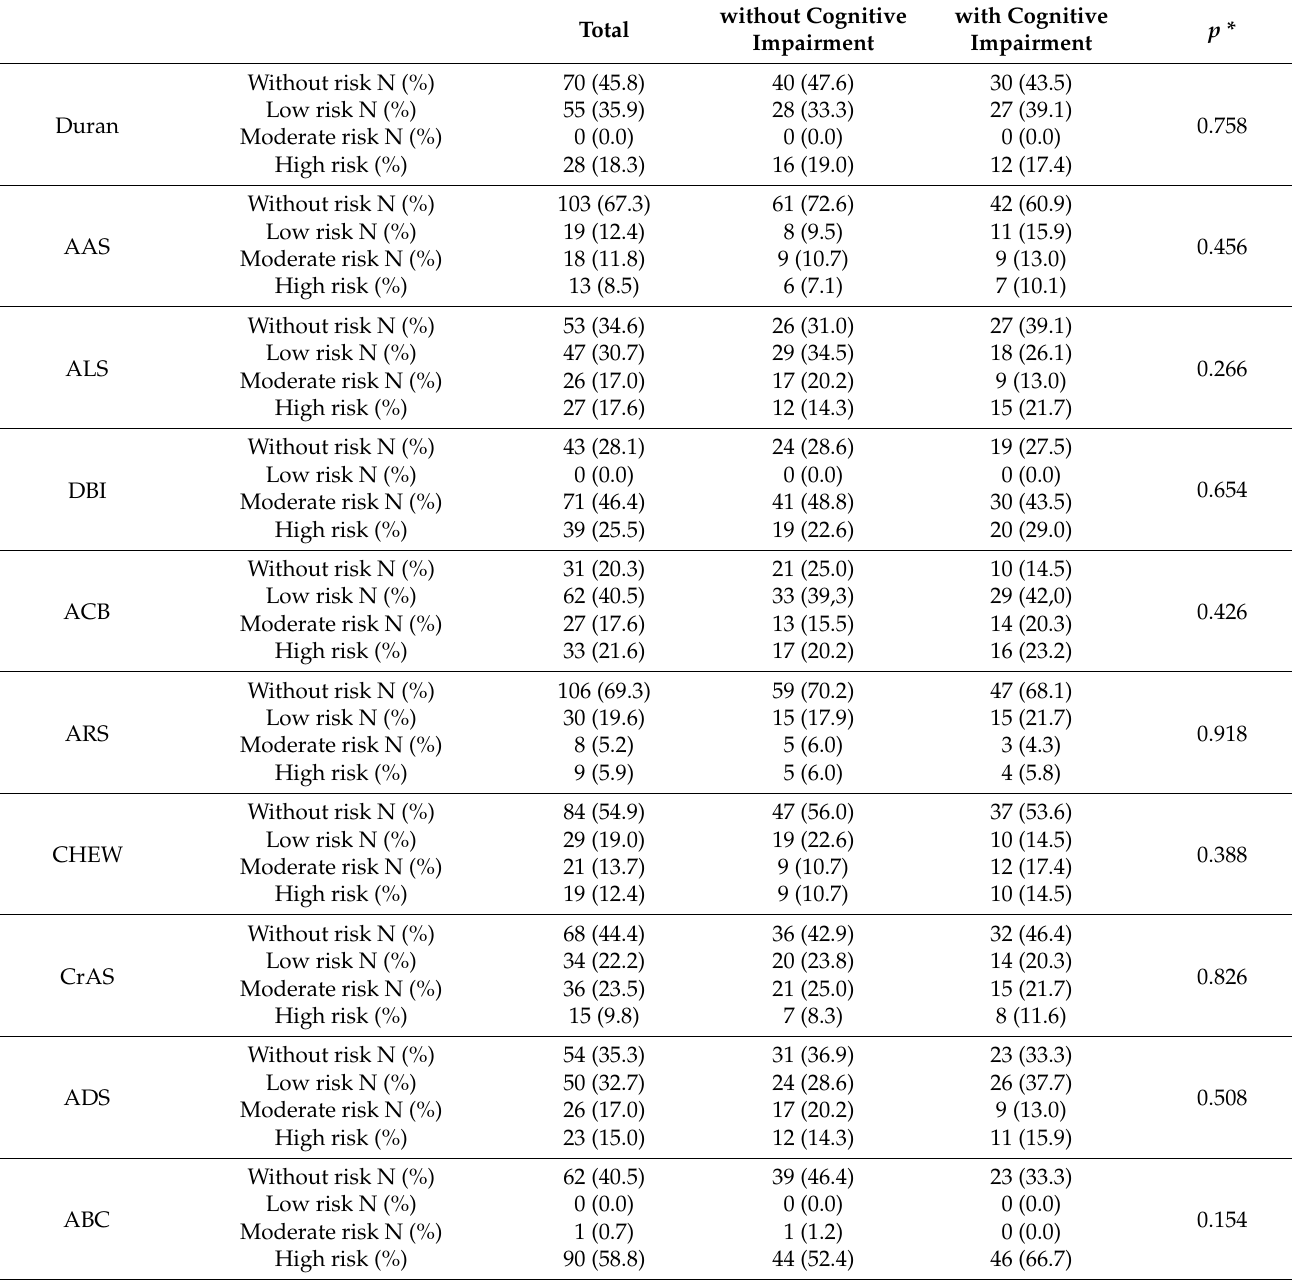
Table A9. Anticholinergic risk by all the scales in subgroups of patients evaluated on 9–12 months, with and without cognitive